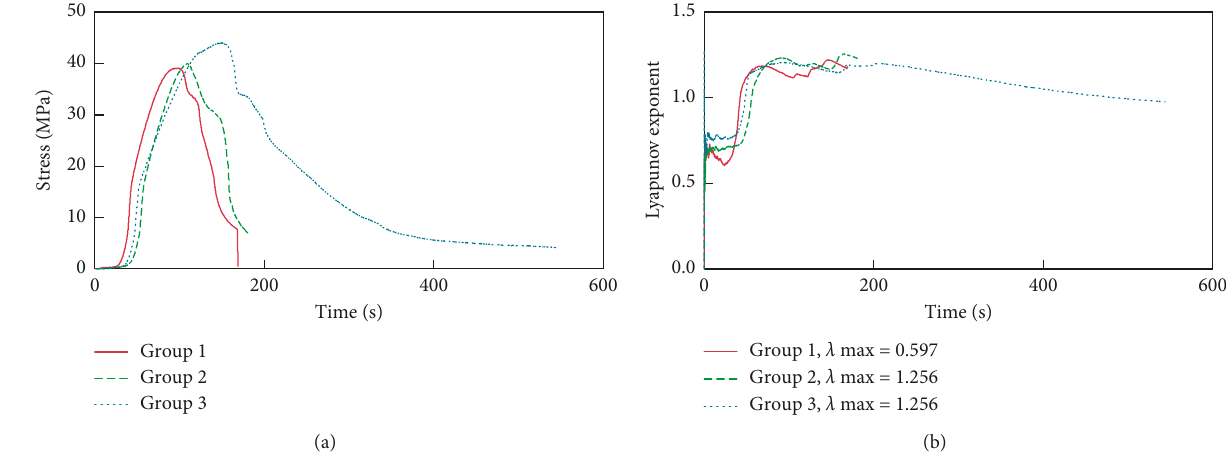
Figure 3: Stress-time curve and LE-time curve of experimental data.